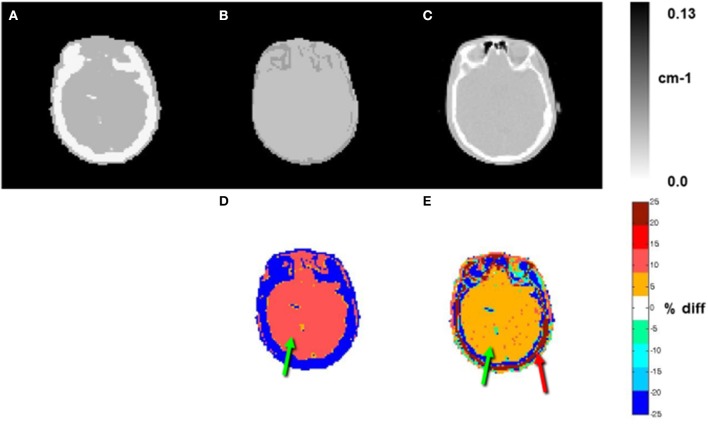
ATN maps of subject 1 (A: Tx, B: DIXON, and C: CT). Relative differences (%) between B and A and between C and A are shown in D and E, respectively. Relative differences for the ATN values for soft tissue of 10 and 5% were observed for the DIXON and CT based ATN maps when compared to the Tx ATN-maps, respectively (green arrows, D and E). Differences of >25% were observed for the osseous tissues between the CT and Tx-based ATN maps (red arrow, E).